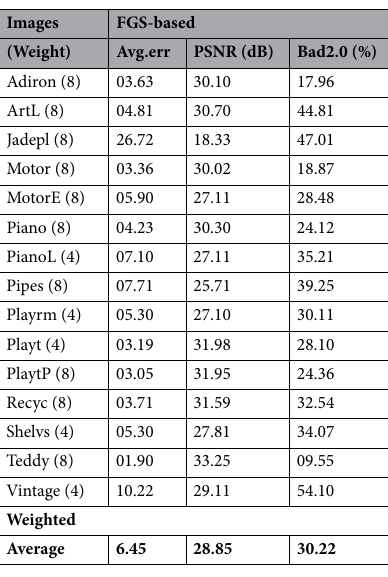
Table 5. All performance measures of the proposed FGS algorithm for the stereo pairs in the current Middlebury evaluation dataset version 3.0. Significant values are in bold. Disparity estimates in the occluded regions were not excluded in the final disparity